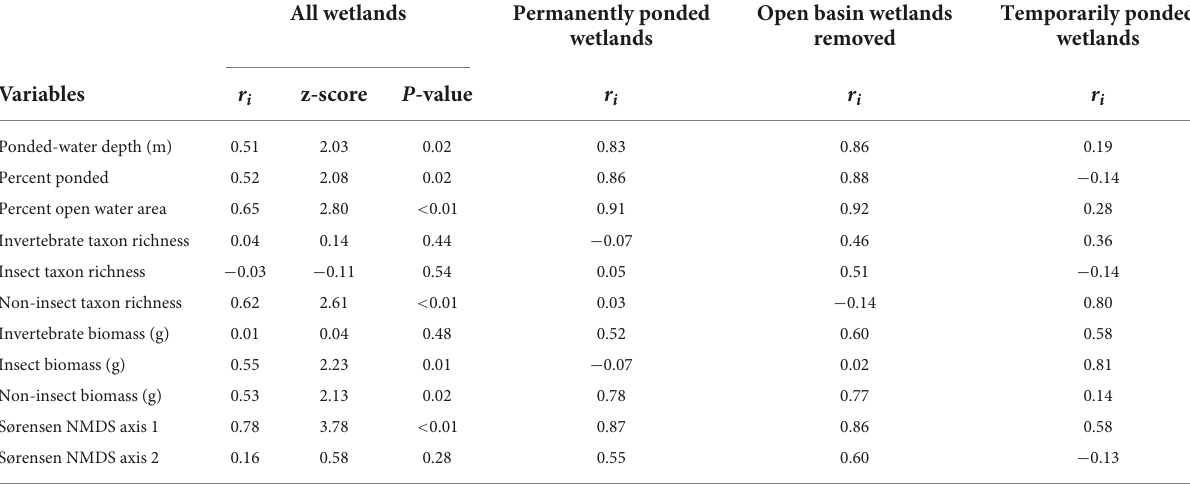
TABLE 3 Intraclass correlation coefficient ( r i ) among all wetlands ( n = 16), just P wetlands ( n = 8), P wetlands excluding OB wetlands ( n -6), and just T wetlands ( n = 8) sampled annually between 1992 and 2015 ( n = 24). All wetlands Permanently ponded Open basin wetlands Temporarily ponded wetlands removed